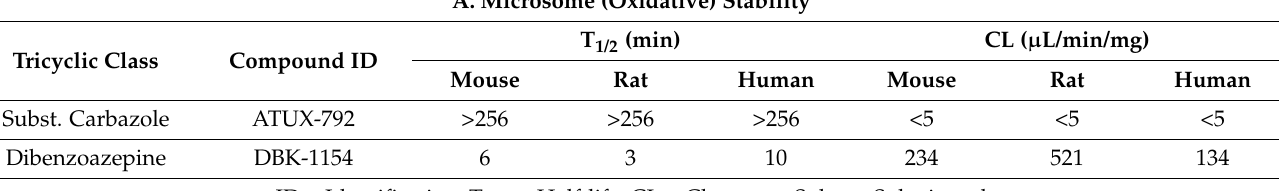
ID = Identification, T 1/2 = Half-life, CL = Clearance, Subst.=